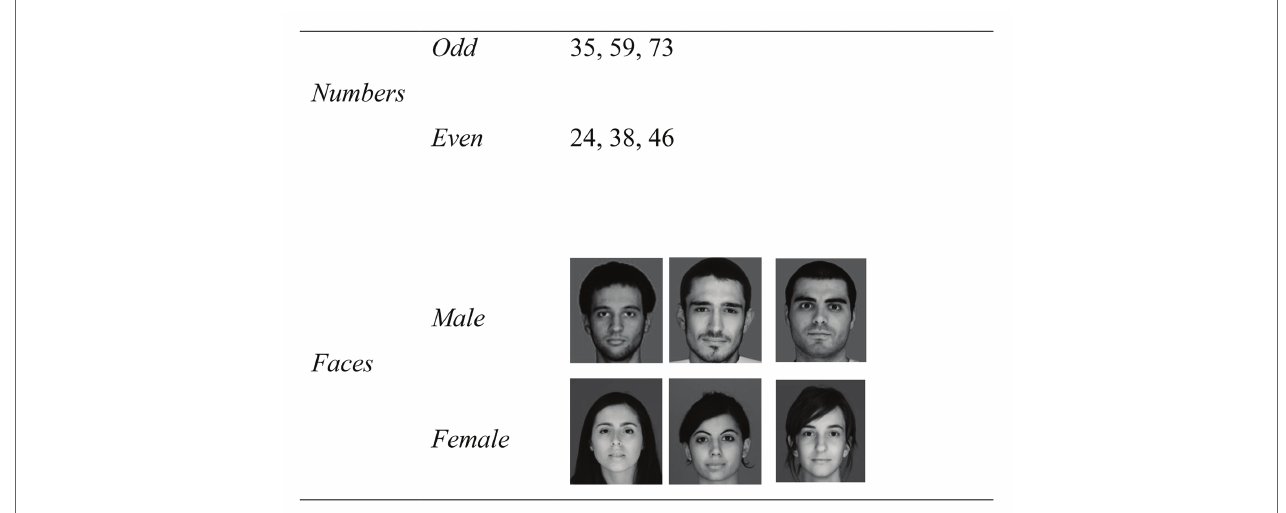
FIGURE 1 | Examples of the stimuli